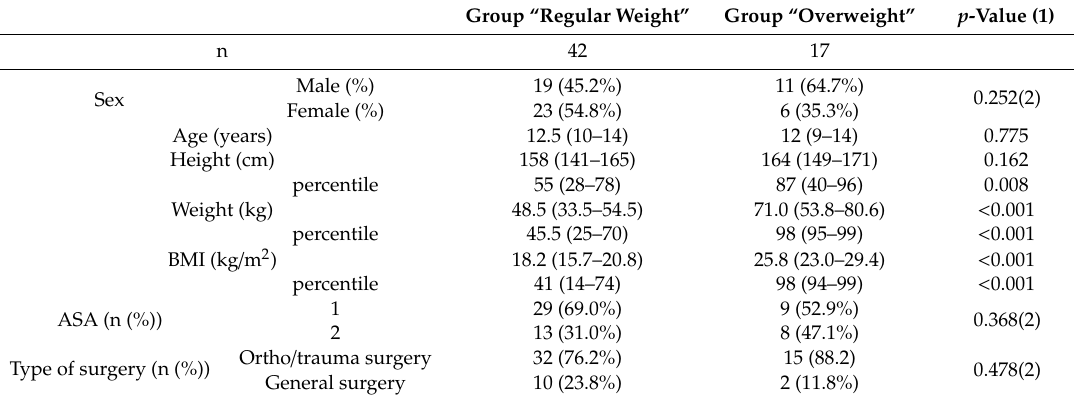
Table 1. Demographic data (median (interquartile range (IQR)); (1) Mann–Whitney U test; (2) Fisher’s exact test; BMI: body mass